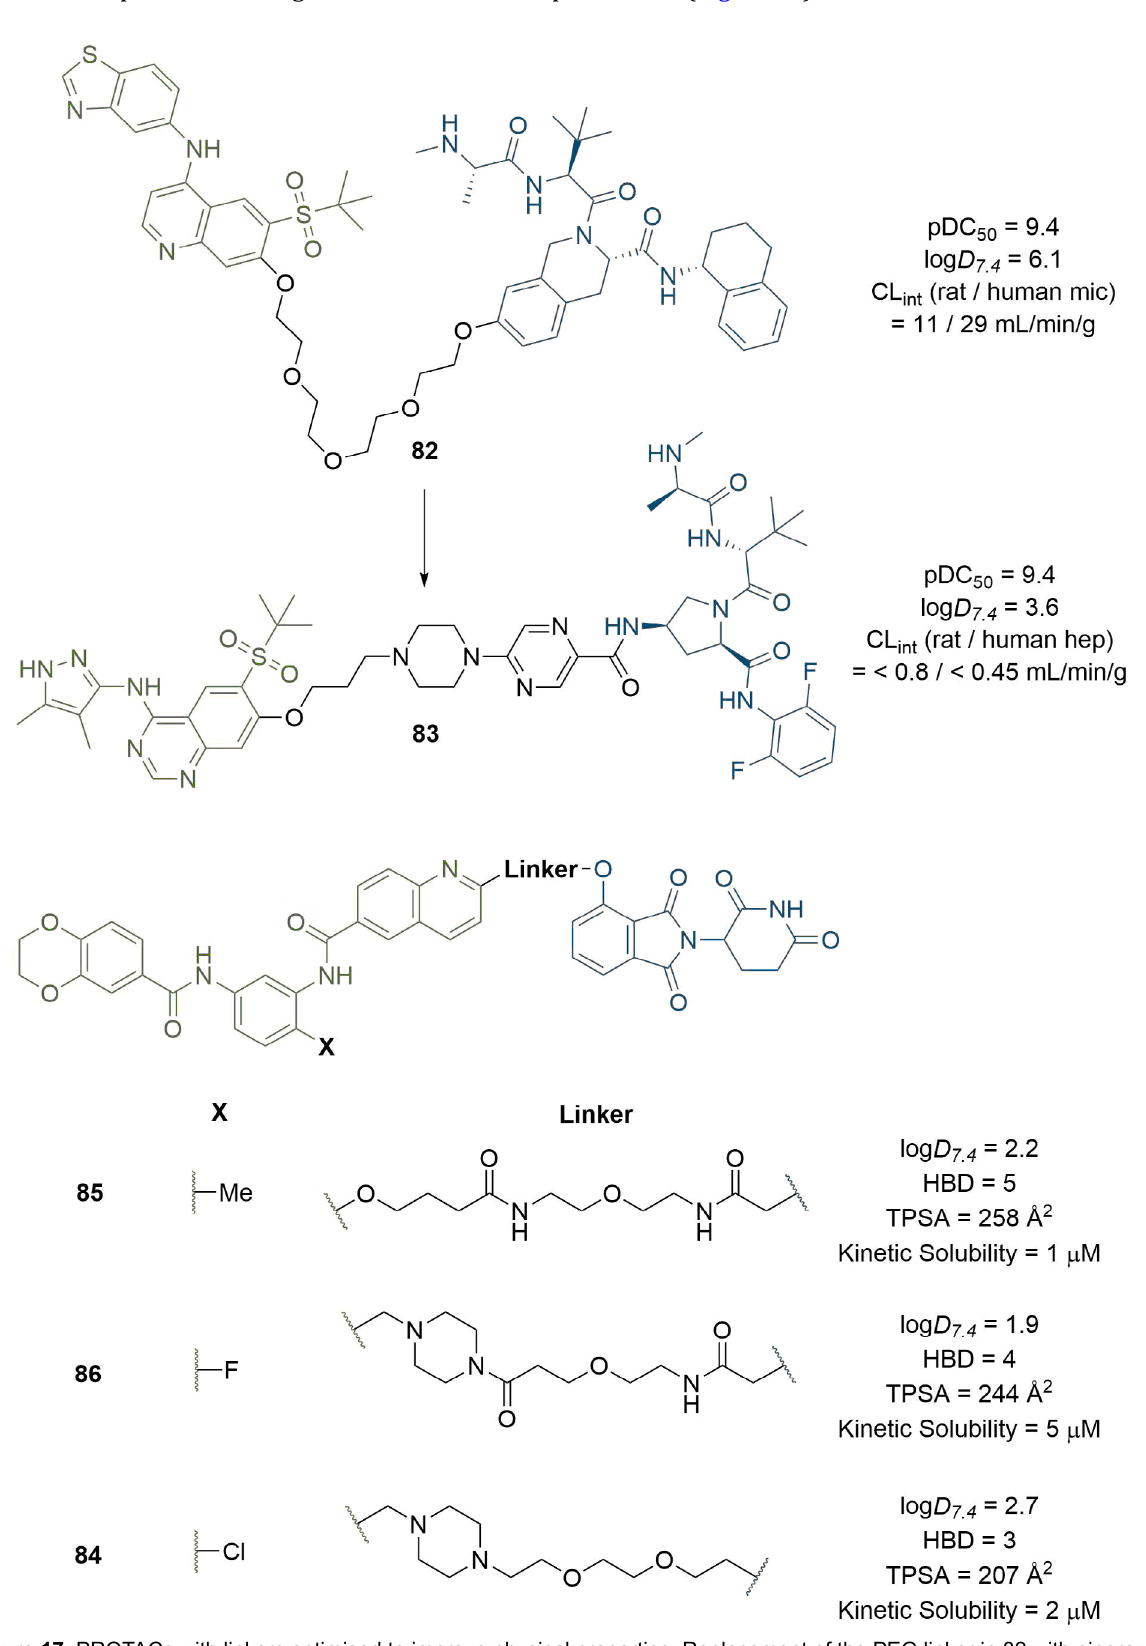
Figure 17. PROTACs with linkers optimised to improve physical properties. Replacement of the PEG linker in 82 with piperazine and pyrimidine moieties (alongside other changes) greatly reduced lipophilicity and metabolic clearance of 83. Chessum et al. [ 126], developed pirin-targeting probe 84 in only three focused design iterations (through 85 and 86) by seeking to optimise physical properties instead of